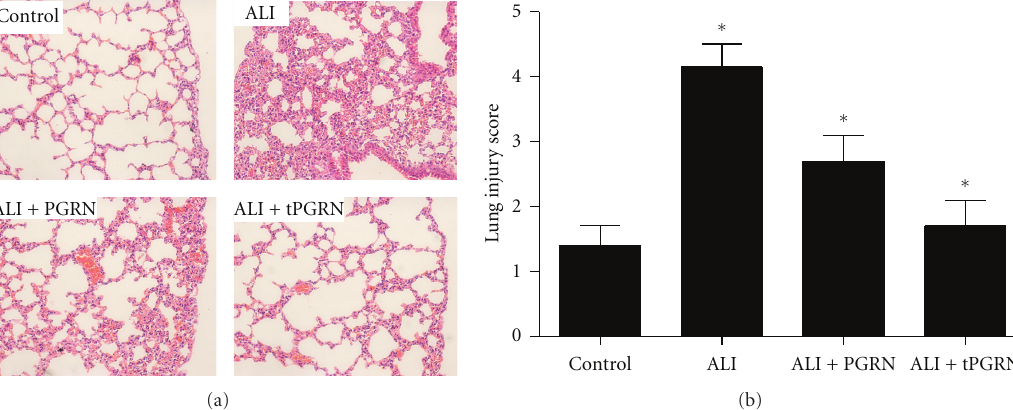
Figure 5: Administration of PGRN ameliorated the histopathology changes of lung in LPS-ALI mice. Groups of mice were treated as described above and then histological evaluation of therapeutic potential of PGRN on LPS-induced lung injury in mice was analyzed at day 3 after LPS challenge. (a) Representative images of hematoxylin and eosin stained lung sections from four experimental groups. (b) Lung injury score was determined. Data are represented as mean ± standard deviation of one experiment consisting of three replicates. ∗ P < 0 .